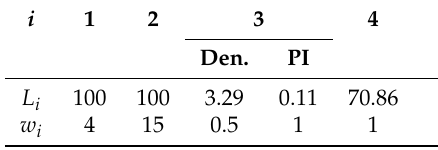
Table 2. Parameters of the objective